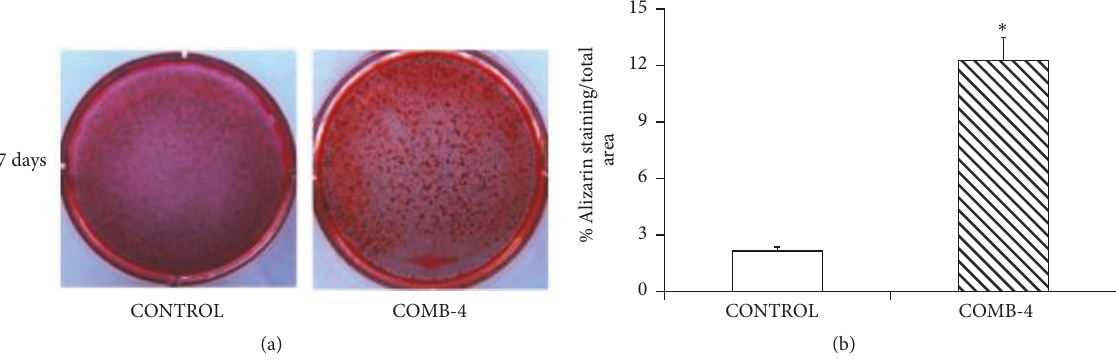
Figure 8: Effect of the incubation of COMB-4 on calcium deposition in differentiated osteoblastic MC3T3-E1 cell line. Panel (a): representative images of MC3T3-E1 cell line differentiated for ten days into osteoblasts and incubated with or without COMB-4 for one week. Calcium deposition after COMB-4 incubation done by Alizarin red S staining. Panel (b): quantitative measurements of Alizarin red S staining of the differentiated MC3T3-E1. Results are expressed as percent of positive Alizarin red area/total area and represent the mean ± SEM of three experiments. ∗ p < 0.05 respect to the control group.